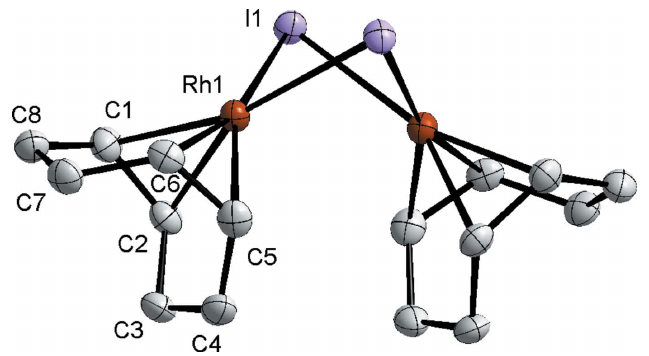
Figure 1 Bent structure of [Rh( (cid:2) -I)(COD)] 2B within the monoclinic C 2/ c polymorph. Independent atoms are labelled, while the other half of the molecule is symmetry-generated through a twofold rotation axis. Ellipsoids are drawn at the 50% probability level. Hydrogen atoms are removed for